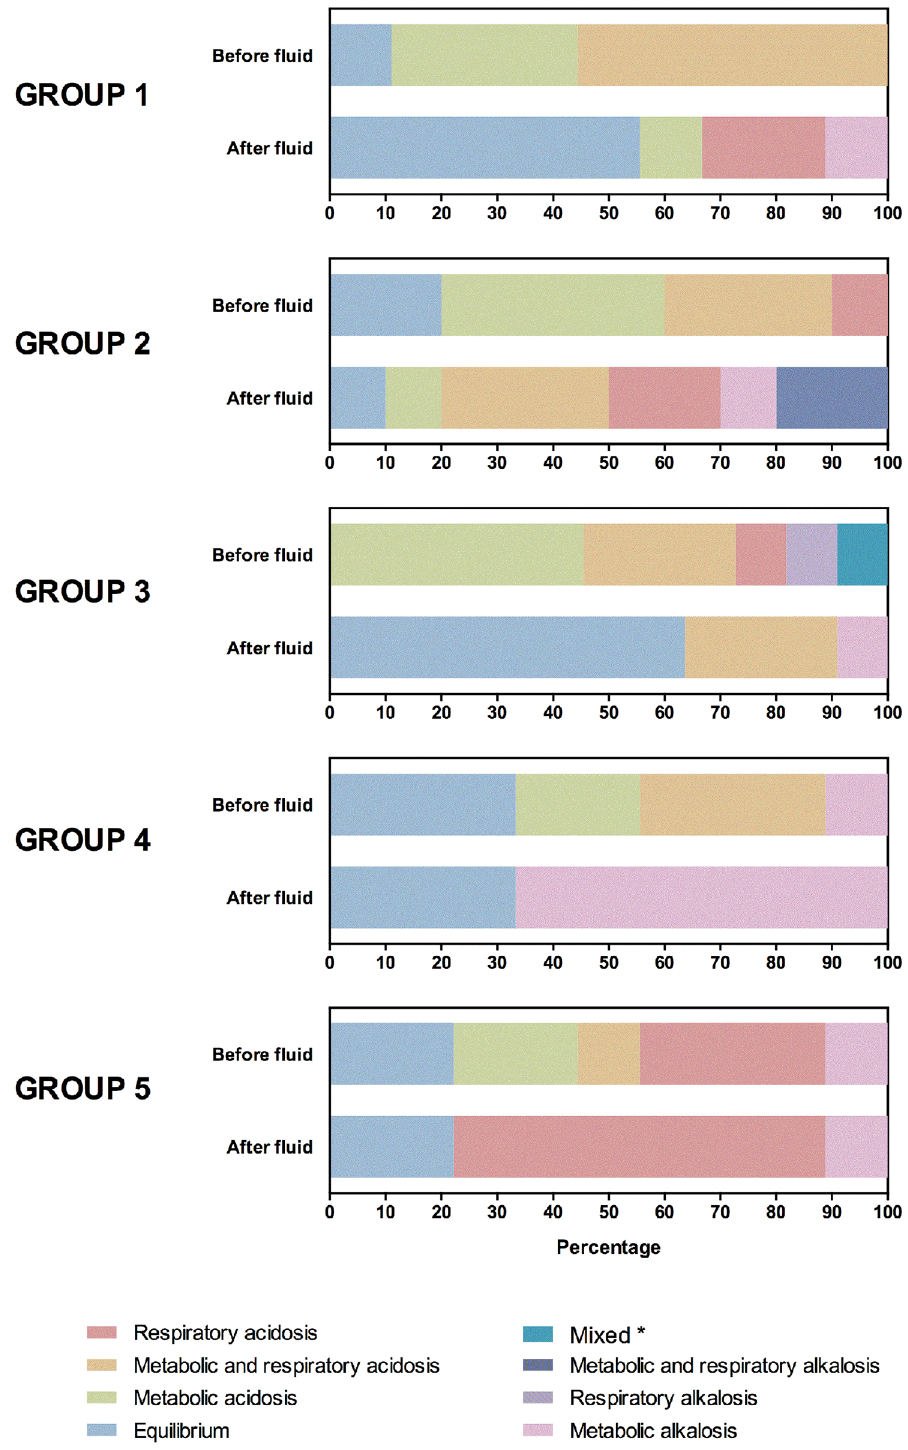
Fig 1. Acid-base status upon admission and after fluid therapy for each group of loggerhead sea turtles. Group 1: 0.9% Na Cl solution; group 2: 5% dextrose + 0.9% Na Cl solutions 1:1; group 3: 0.9% Na Cl and lactated Ringer's solutions 1:1; group 4: lactated Ringer's solution; group 5: untreated turtles. * metabolic acidosis and respiratory alkalosis.